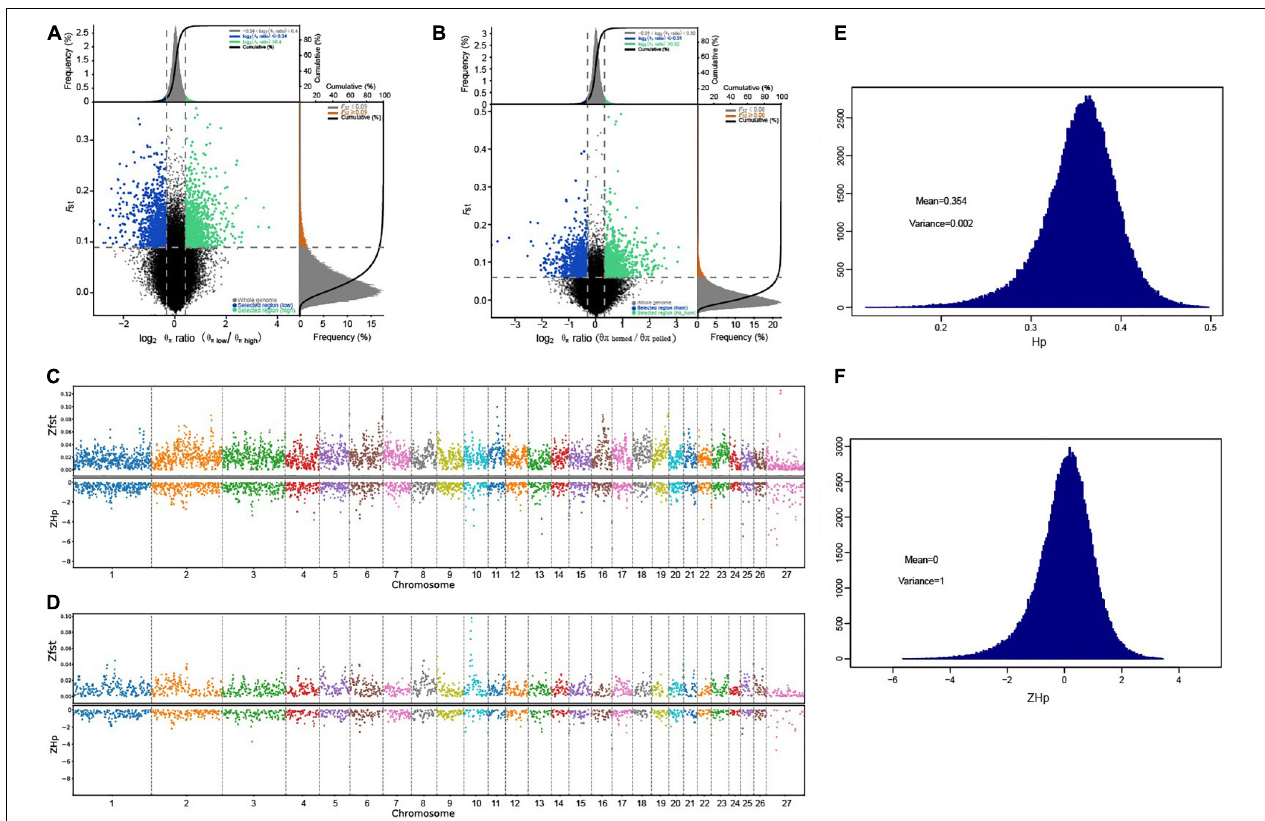
FIGURE 3 | Selection sweep analysis. (A) FST and θπ ratio selective elimination analysis chart for adaptive traits. (B) FST and θπ ratio selective elimination analysis chart for horn traits. The abscissa is the θπ ratio value, and the ordinate is the FST value, corresponding to the frequency distribution diagram above and the frequency distribution diagram on the right, respectively, and the dot diagram in the middle represents the corresponding FST and θπ ratio values in different windows. The blue and green areas are the top 5% areas selected by θπ and FST. (C) Distribution of ZFST and ZHp on the chromosome for adaptive traits. (D) Distribution of ZFST and zHp on the chromosome for horn traits. The larger the ZFST value (upper half), the more obvious the species differentiation and the higher the degree of selection. The smaller the zHp value (lower half), the smaller the heterozygosity of the species in this window, indicating a higher degree of selection. (E) Distribution of Hp scores. The abscissa indicates the heterozygosity rate, and the ordinate indicates the heterozygosity rate distribution; µ , mean, σ and standard deviation. (F) Standardized normal distribution of Z-transformed Hp scores. The abscissa represents the heterozygosity rate, and the ordinate represents the distribution of zHp; µ , mean, σ and standard